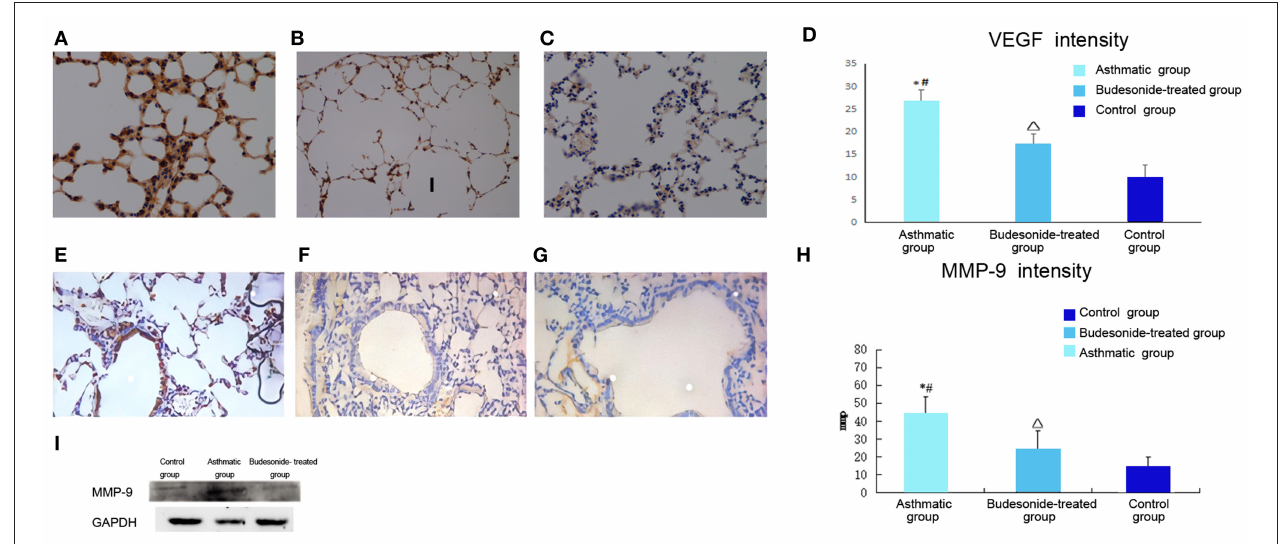
FIGURE 3 | VEGF, MMP-9 expression increased in asthmatic mice. (A–D) Expression of VEGF in lung tissues. (A) The asthmatic group, (B) the budesonide-treated group, (C) the control group. Magnification × 200. (D) VEGF protein expression quantified with Image J. Expression of VEGF in lung tissues was investigated using immunohistochemistry (A–D) . VEGF expression was increased in the asthmatic group compared with that in the normal control group and decreased in the budesonide-treated group. * P < 0.01, the asthmatic group vs. the normal control group, # P < 0.01, the asthmatic group vs. the budesonide-treated group, N P < 0.01, the budesonide-treated group vs. the normal control group. (E–I) Expression of MMP-9 in lung tissues. (E) The asthmatic group, (F) the budesonide-treated group, (G) the normal control group. Magnification, × 200. (H) MMP-9 protein expression quantified with Image J. (I) Western blotting expression of MMP-9. Expression of MMP-9 in lung tissues was investigated using immunohistochemistry (E–H) . MMP-9 expression was increased in the asthmatic group compared with that in the control group and decreased in the budesonide-treated group. * P < 0.01, the asthmatic group vs. the control group, # P < 0.01, the asthmatic group vs. the budesonide-treated group, N P < 0.01, the budesonide-treated group vs. the control